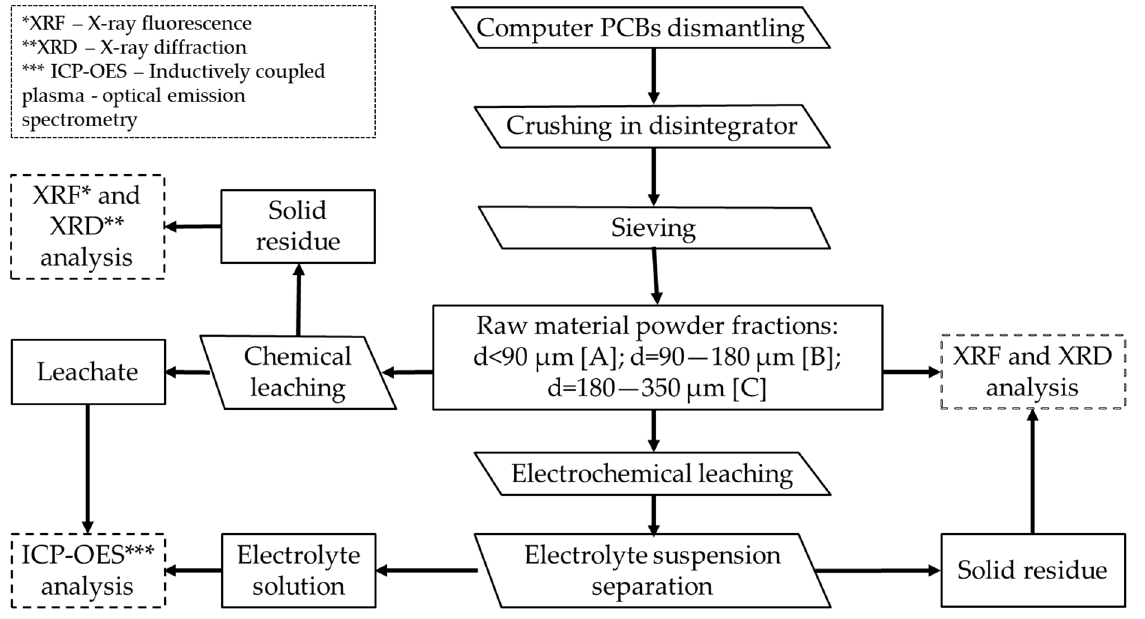
Figure 1. Schematic diagram of the process investigated.